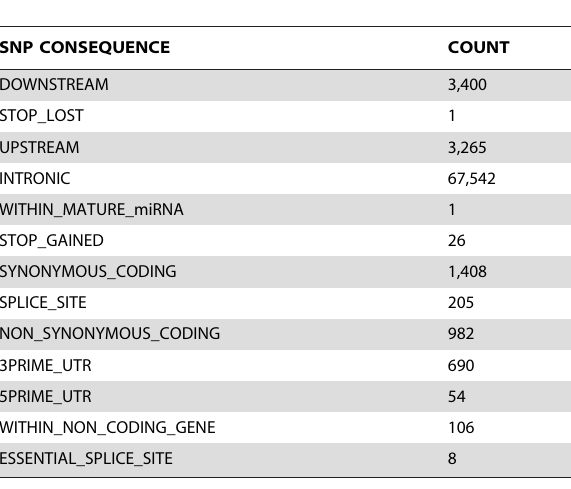
Table 3. Counts of BWA/GATK SNPs of each consequence within gene